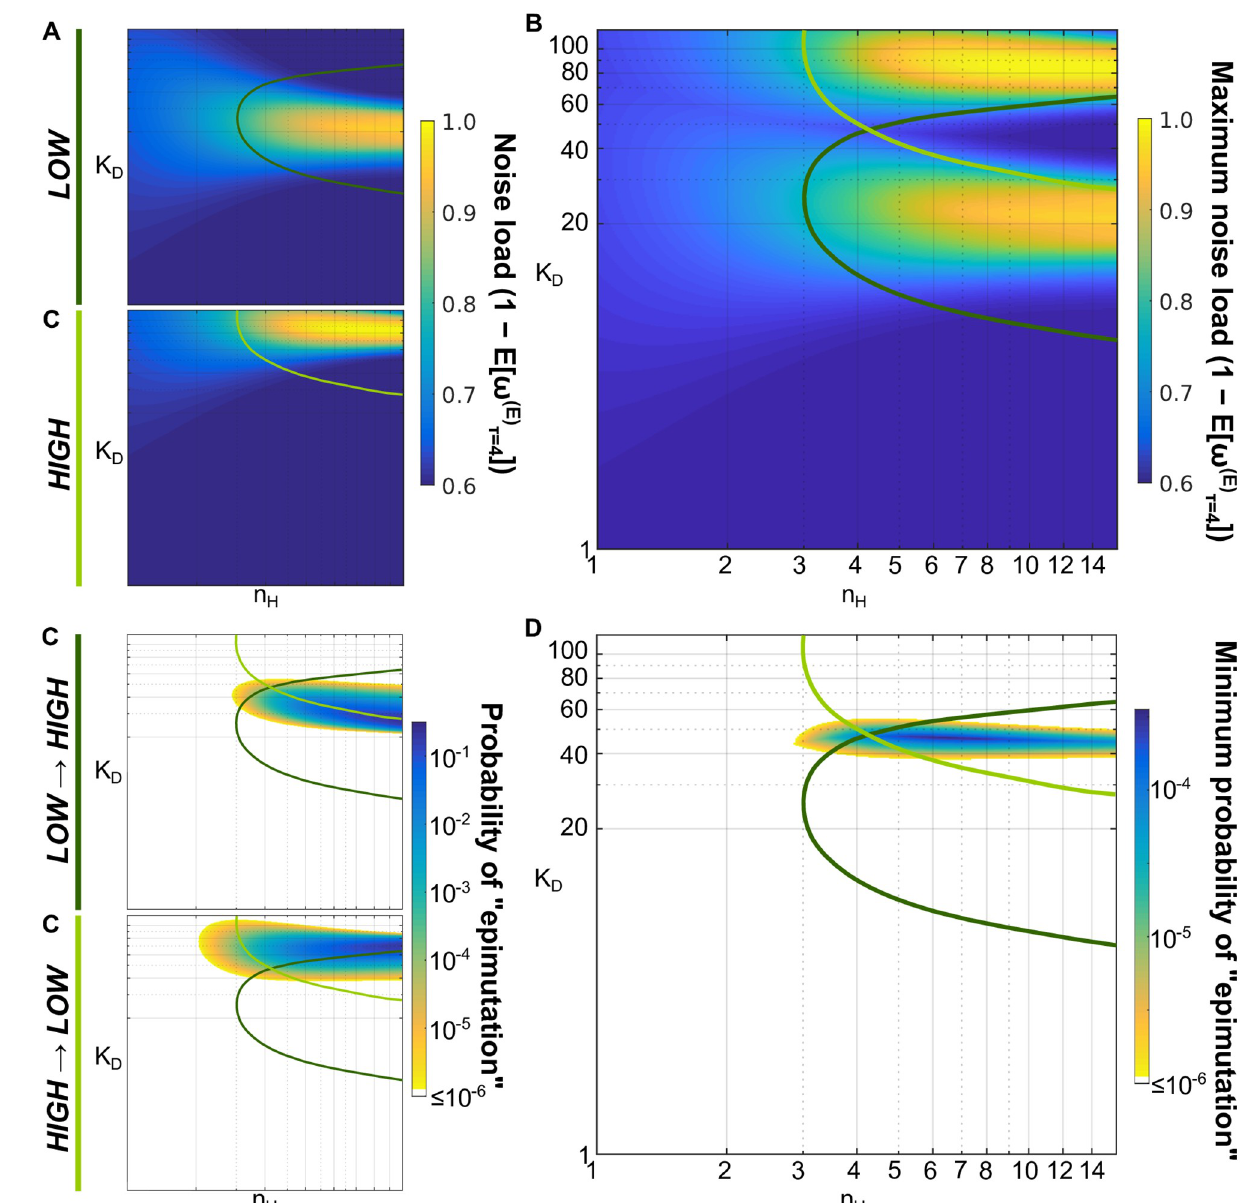
Fig 7. Increasing nonlinearity reduces the noise load in the bistable region, decreasing also the epimutation rate. (A) The noise load (Eq 11) is calculated for the solution genotypes y ð E Þ for each environmental state, LOW and HIGH . (B) The maximum noise load comparing y ð E Þ � environmental states for each value of n H and K D (with k ð E Þ depending on the environment being considered). (C) The probability of an individual with a � solution genotype y ð L Þ (or y ð H Þ ) and initial phenotype A ( L ) (or A ( H ) ) has a good fitness score ω in the alternative environment at the end of the generation, � � i.e. ω ( H ) ( A ) � 0.5 (or ω ( L ) ( A ) � 0.5), which is considered as a LOW ! HIGH “epimutation” (or HIGH ! LOW “epimutation”). (D) The minimum τ =4 τ =4 probability of “epimutation” comparing y ð E Þ in both directions, LOW ! HIGH and HIGH ! LOW , for each value of n � the environment being considered). Values less or equal to 10 − 6 are omitted. Same range of values and bistable region lines as in Fig